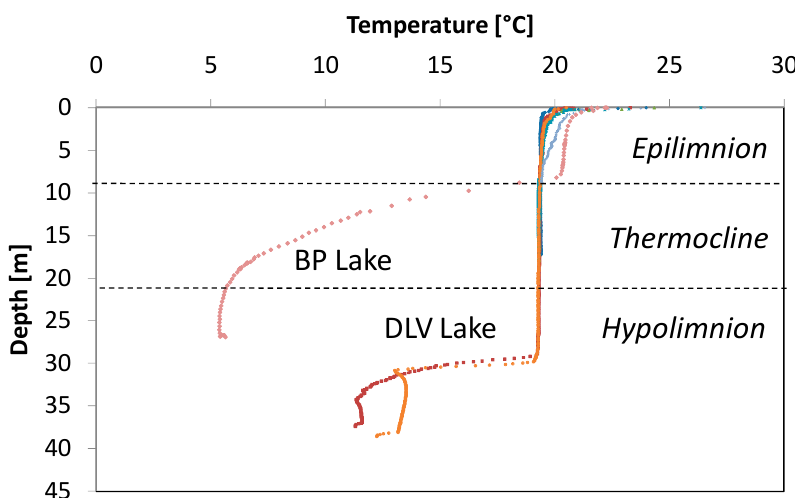
Figure 3. Temperature versus depth profiles at five different locations in DLV Lake and in one location in BP Lake, measured in August 2012.